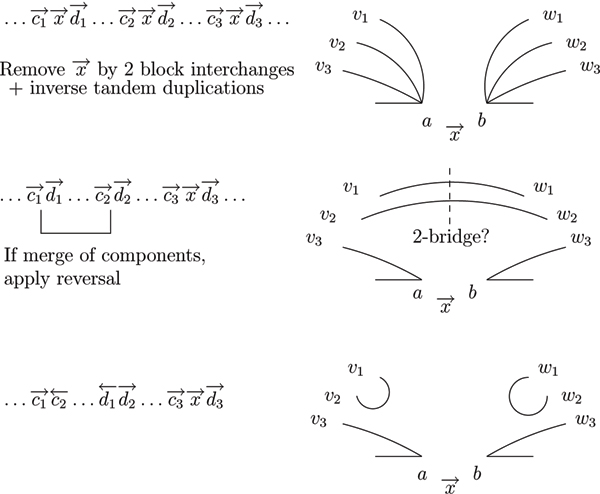
Sequences for elements with multiplicity = 3. An example for a sequence if an element × has a multiplicity ≥ 3. First, we remove two of the copies of x by two block interchanges and inverse tandem duplications. If this merges two components, the component can be cut by an additional reversal. For other orientations of the element x, similar sequences can be applied.